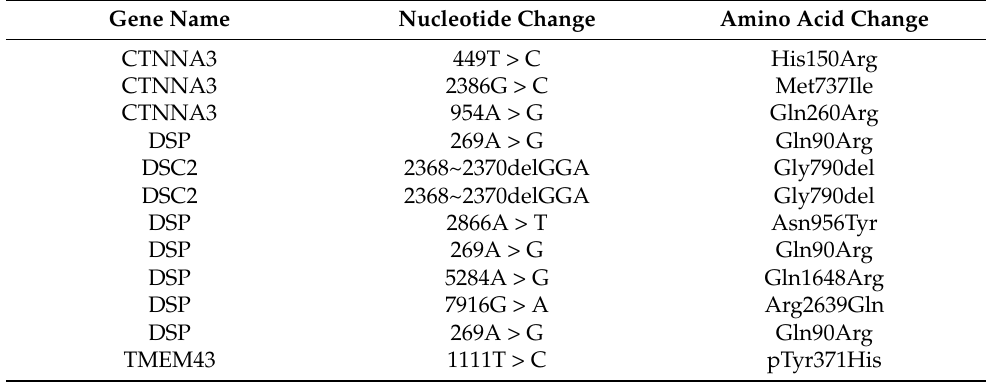
Table A1. Potential pathogenic mutations in autopsied patients with